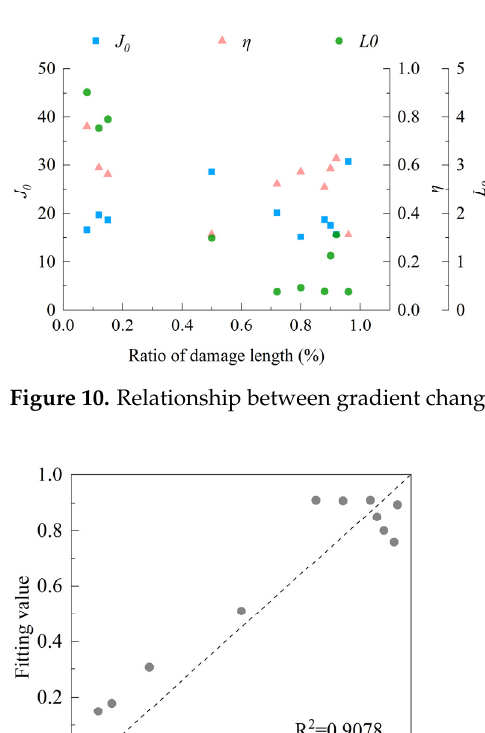
Figure 9. The relationship between the gradient of the drainage channel and damage type.